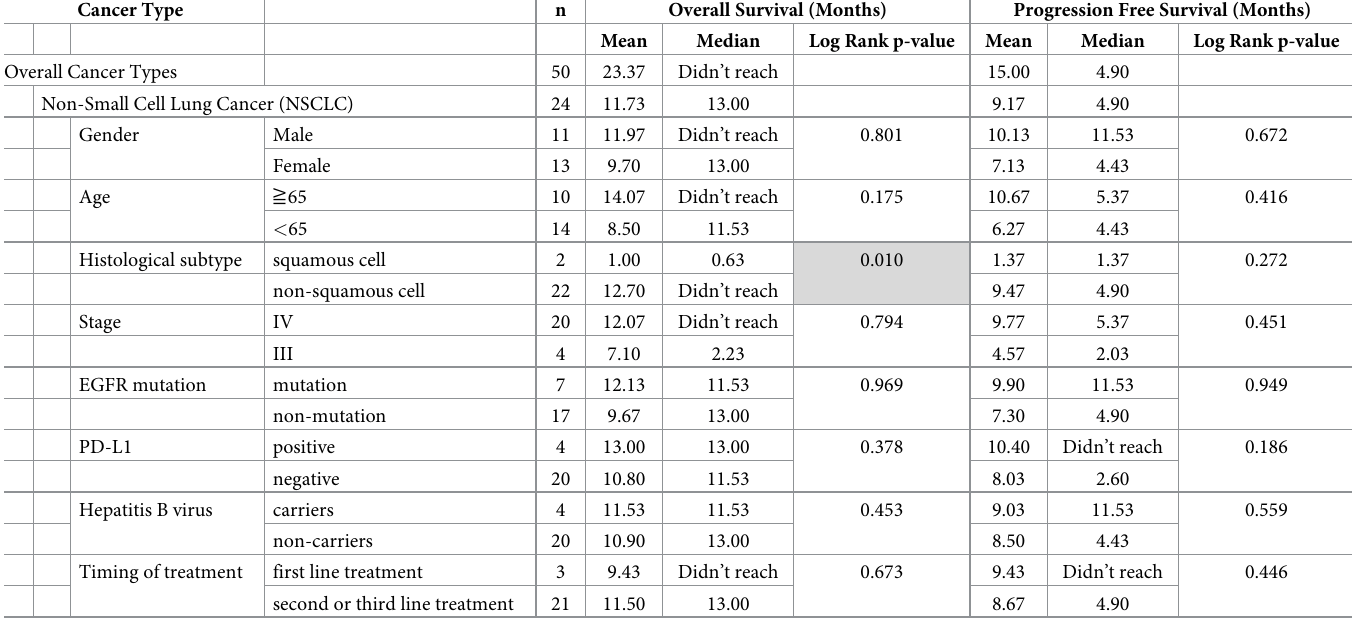
Table 4. Effectiveness of